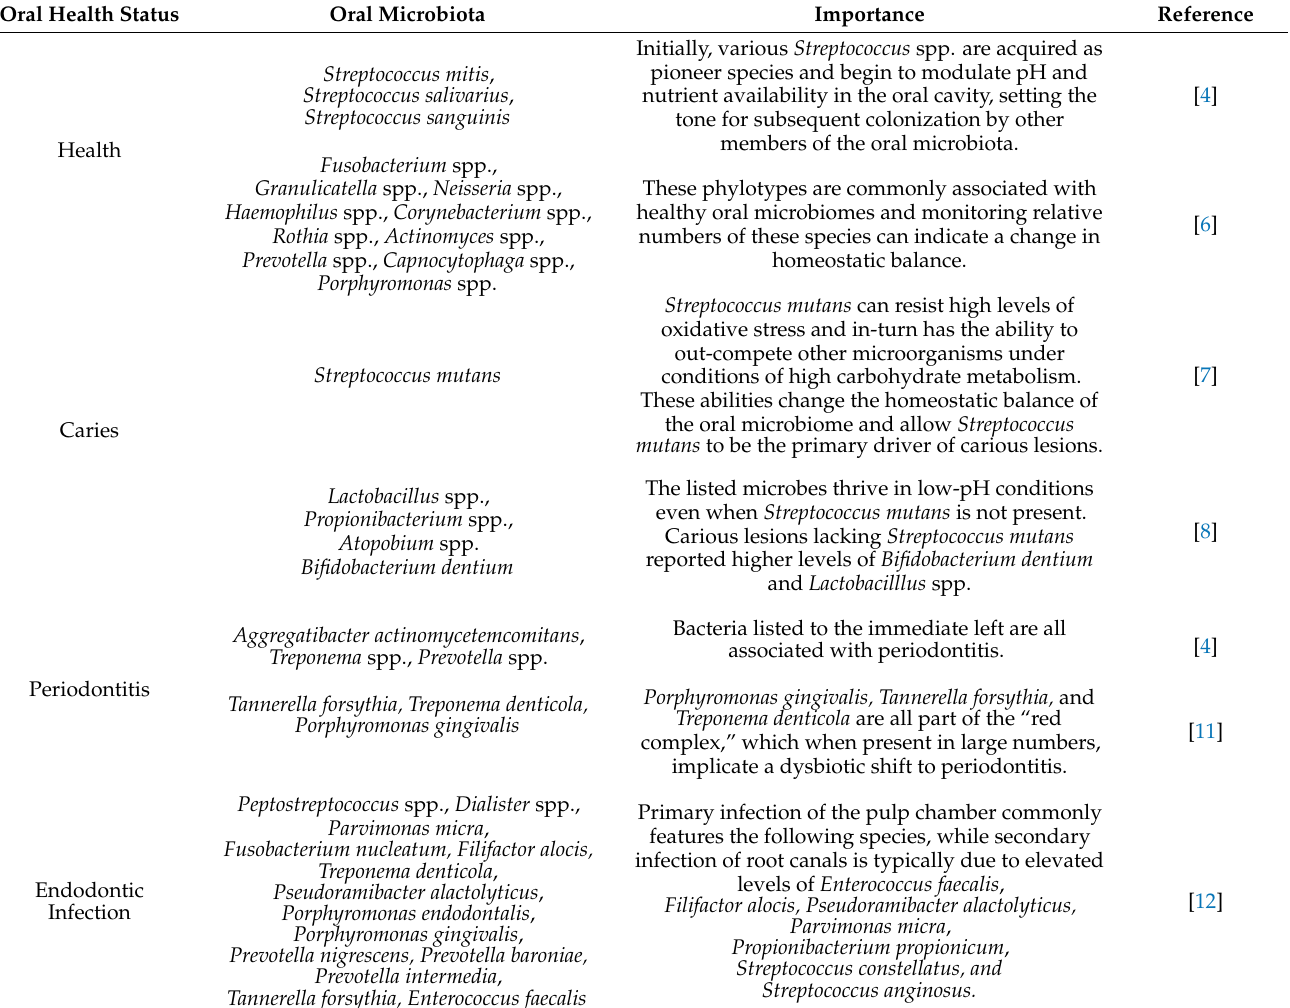
Table 1. Importance of specific oral microorganisms according to oral health